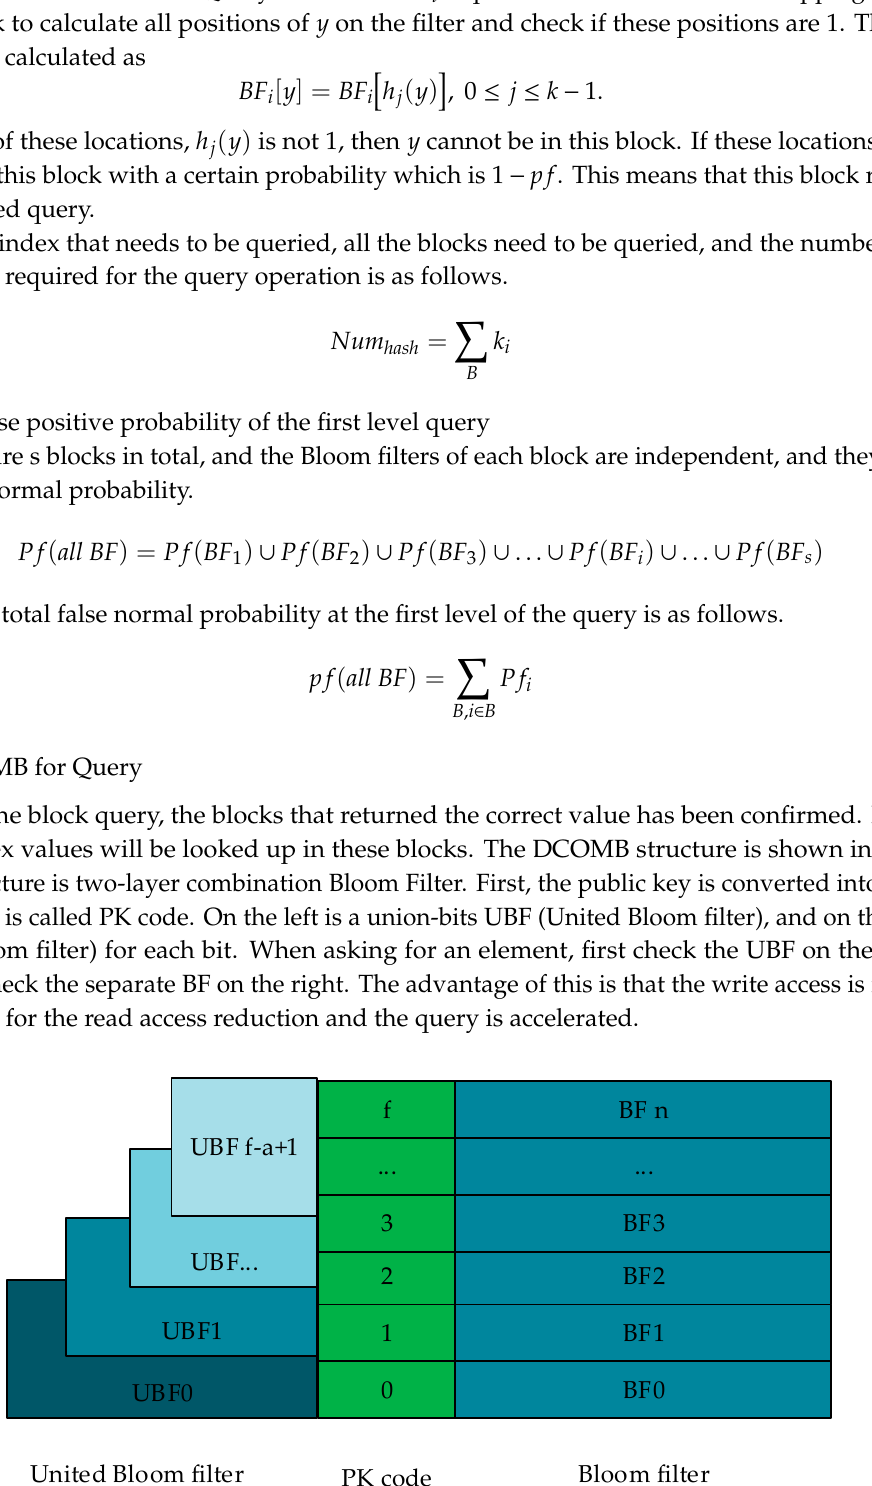
Figure 8. The Dual COMB structure .